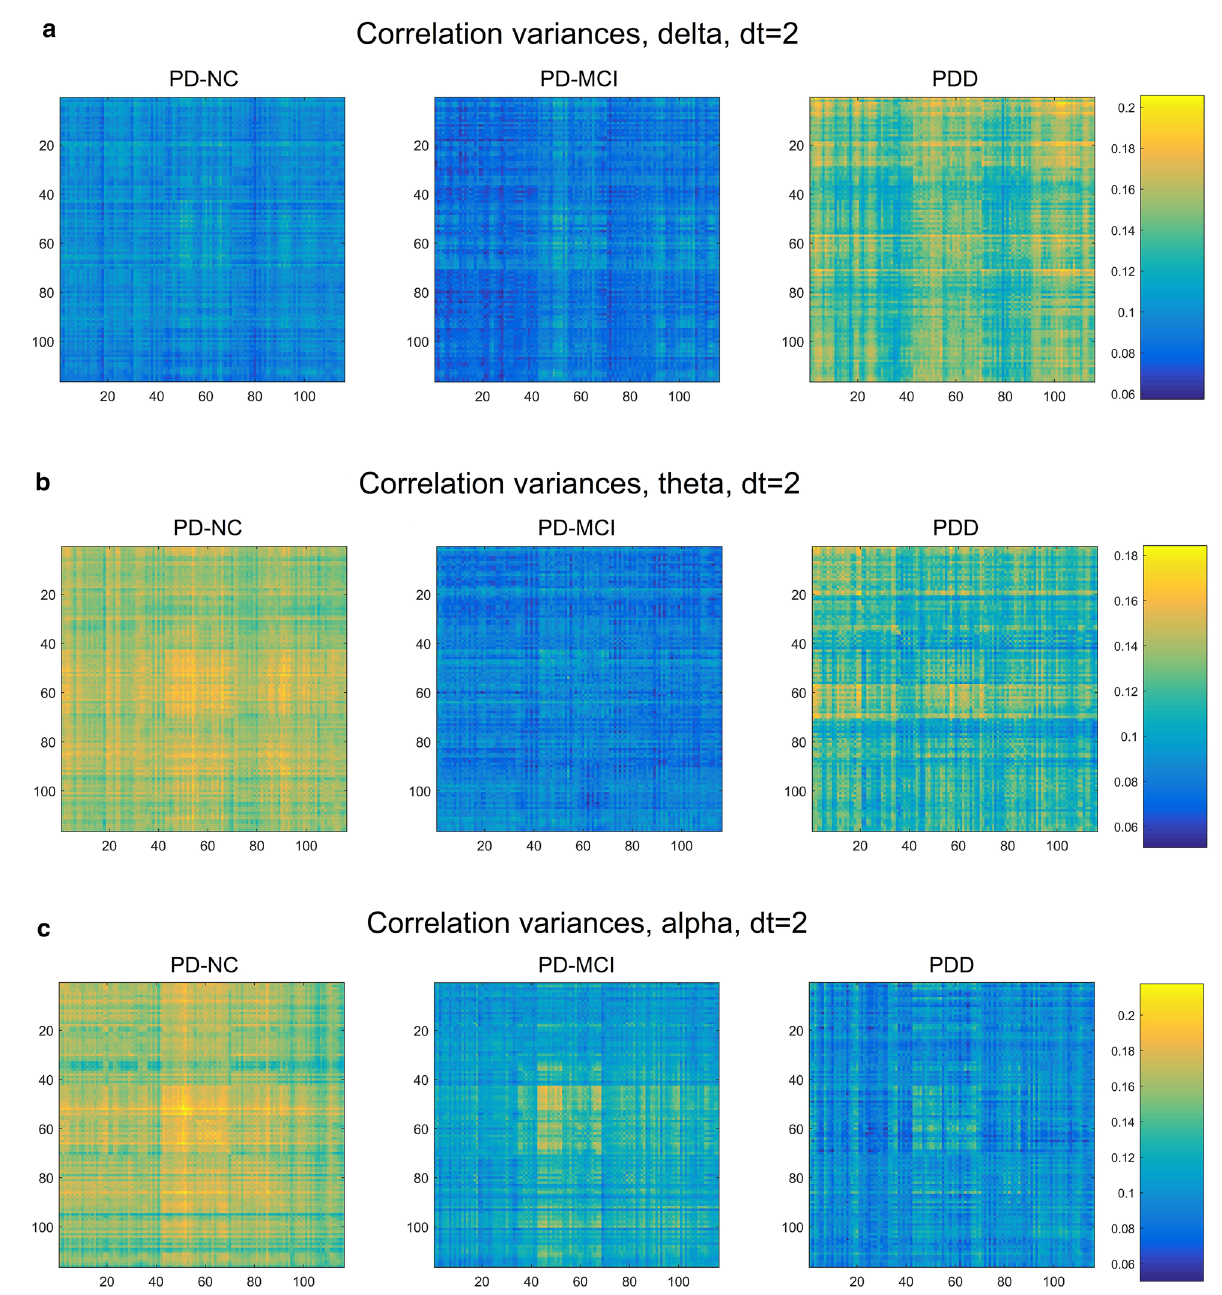
Figure 7. Correlation variance maps. For all brain-wave frequency bands except delta, there is a marked, mostly global drop in correlation variability from PD-NC to PD-MCI groups [( a ) delta, ( b ) theta, ( c ) alpha, ( d ) beta, ( e ) gamma]. The two lower-frequency bands show a partial recovery in variability in the PDD